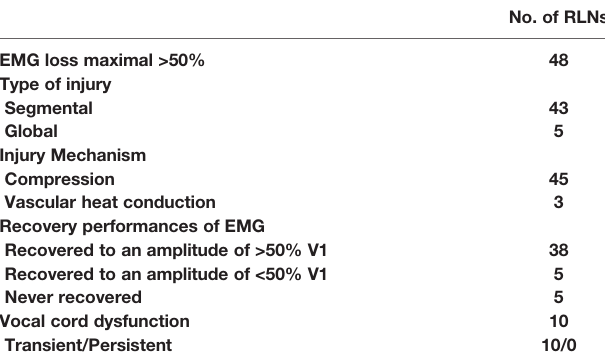
TABLE 5 | EMG changes of RLN and vocal cord dysfunction in